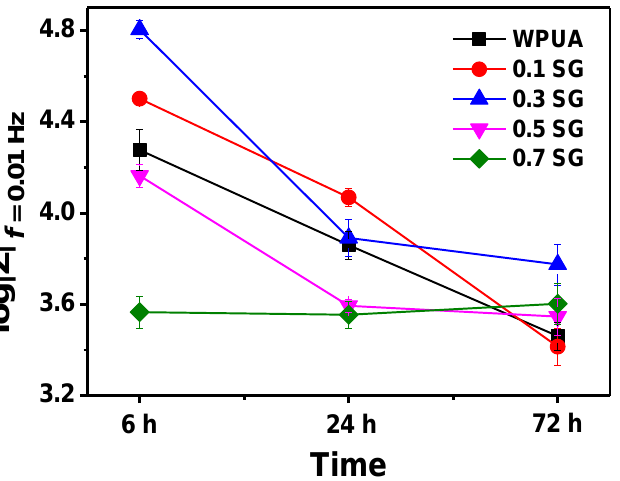
Figure 9. The variation on the impedance modulus (|Z| f = 0.01 Hz ) for the different coating samples as a function of immersion time.